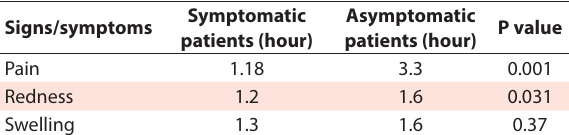
Table 1. The relationship between the duration of the sting and the patient’s referral to the center and the emergence of symptoms Signs/symptoms